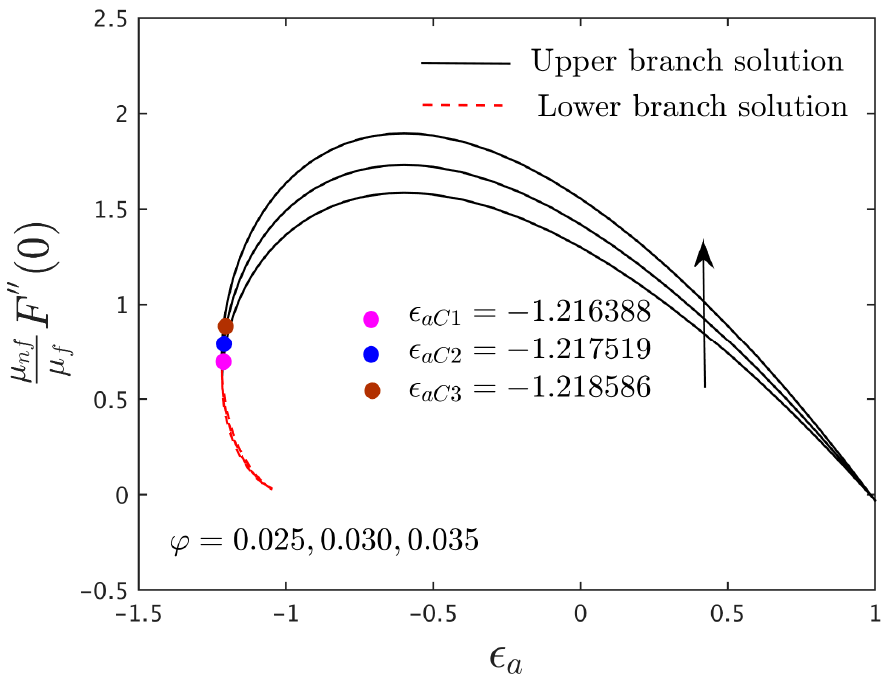
ε for the numerous values of